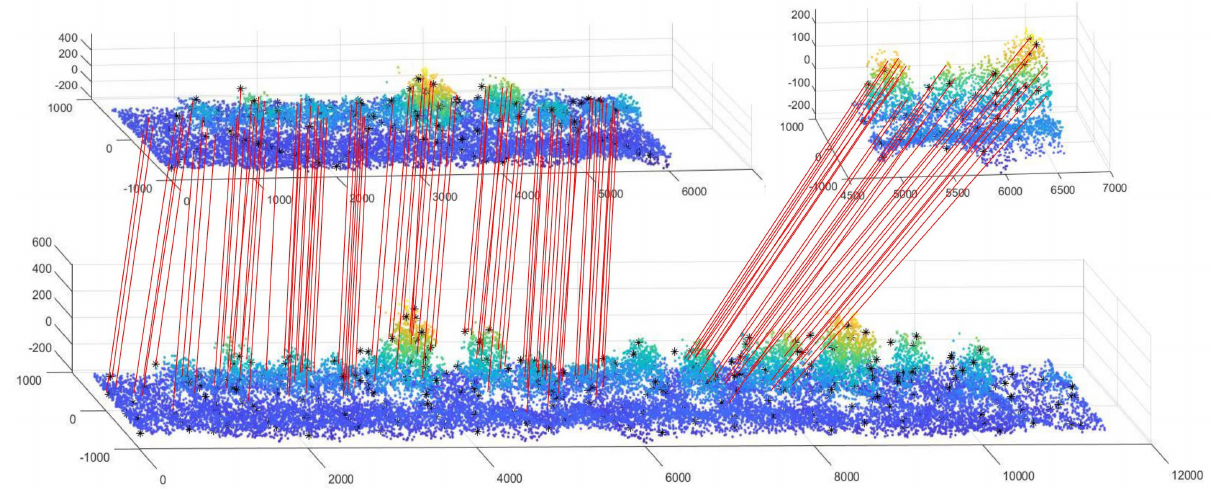
Figure 8. Matching correspondences between key points from L-PC (upper—two captured partial sections) to G-PC(lower). Source: